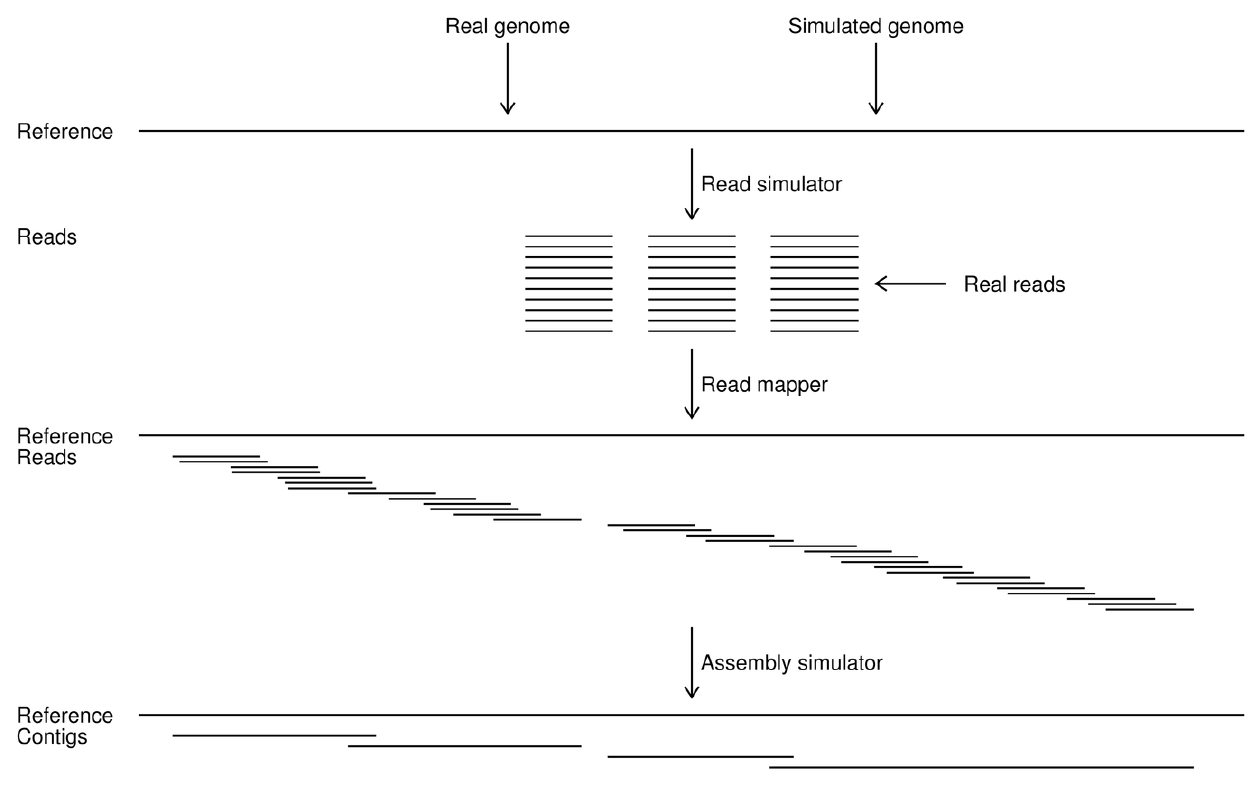
Figure 2. Work flow in the assembly simulations. A reference genome is first chosen as either a known sequence or is simulated from a previously determined one. Reads are then simulated from the reference or taken as a set of real reads for the known genome. The simulated or real reads are mapped to the reference and a set of simulated contigs is generated by the assembly simulator. This study provides the read and assembly simulators. The read mappings in this paper were done with the CLC Assembly Cell programs [24], but can be accomplished with any standard read mapping software (e.g.,